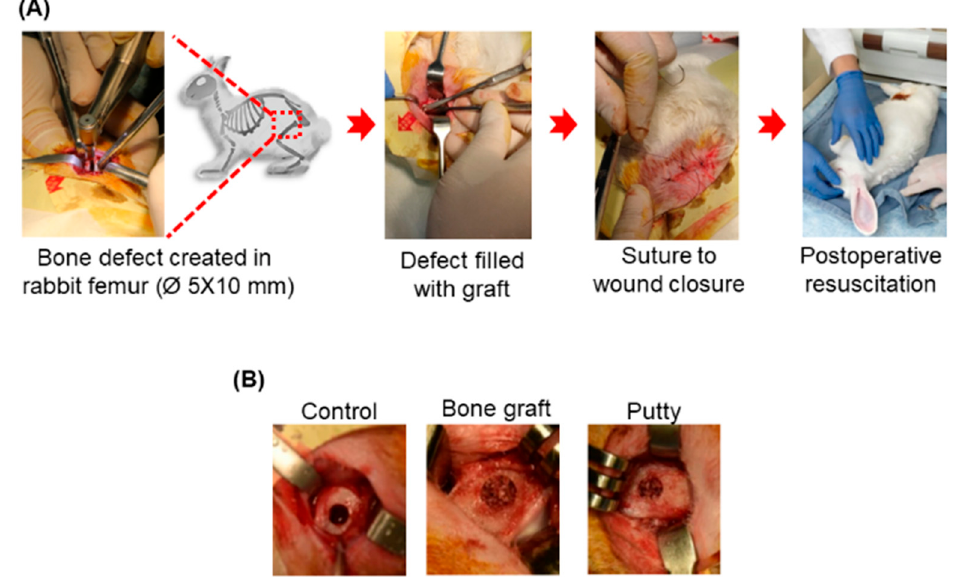
Figure 3. Schematic representative picture of the gross appearance of the critical-sized bone defects. ( A ) Creation of the critical-sized bone defect (Ø 5 × 10 mm) in rabbit femoral condyle. ( B ) Implanted critical-sized bone defect with bone graft and putty.